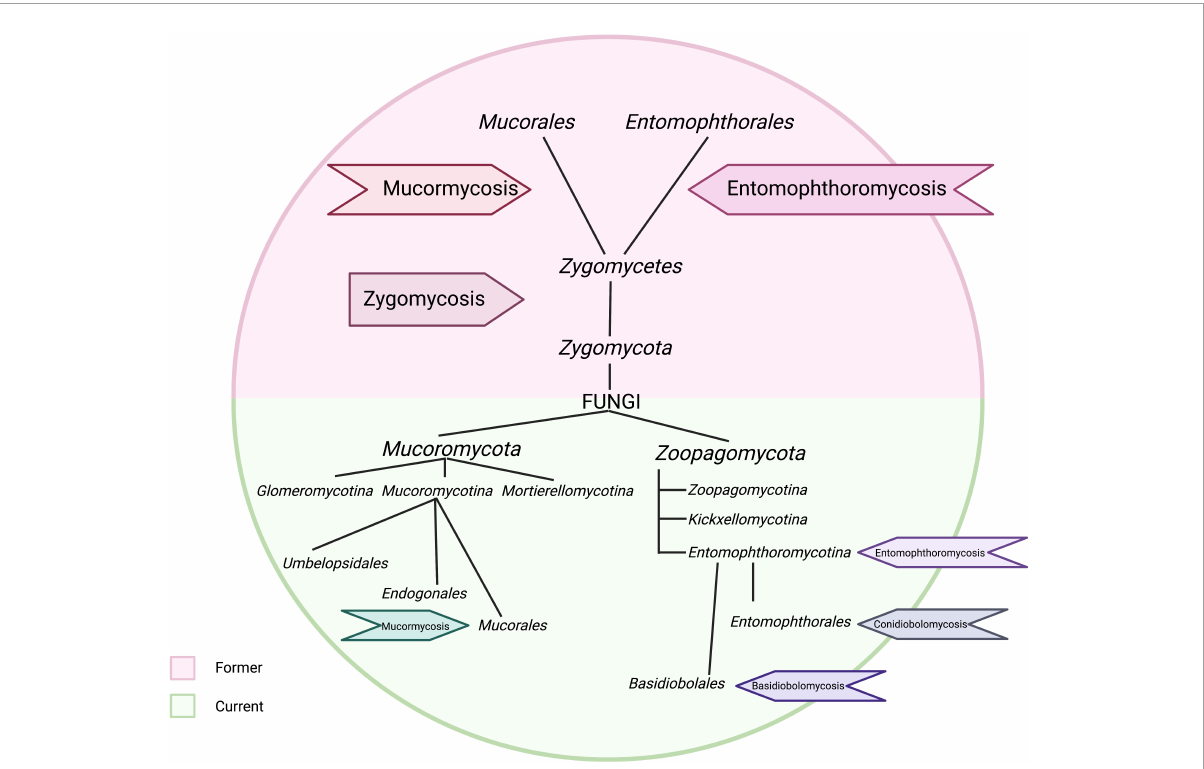
FIGURE2 Taxonomy and terms used in mucormycosis and entomophthoromycosis. This image shows the old nomenclature for zygomycosis in the light purple section. The current taxonomic classification and terminology is indicated in the light green section. This image was created with